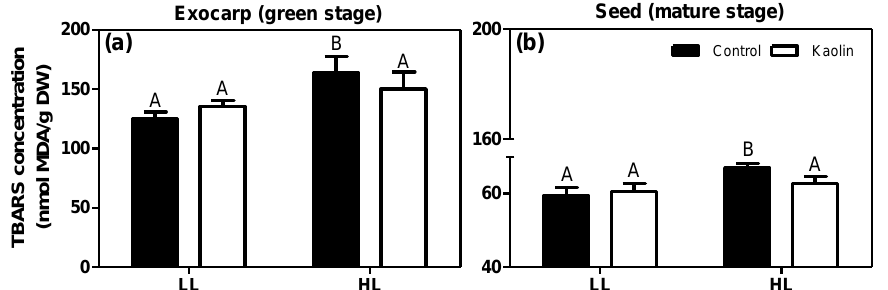
Figure 9. Levels of thiobarbituric acid-reactive-substances (TBARS; in nmol MDA/g DW) in green exocarps ( a ) and mature seeds ( b ). Grape berries were from LL and HL microclimates and from plants with or without (control) foliar kaolin application. Different capital letters above the bars refer to significant differences between microclimates within the same treatment ( p ≤ 0.05; n = 3 or 4).